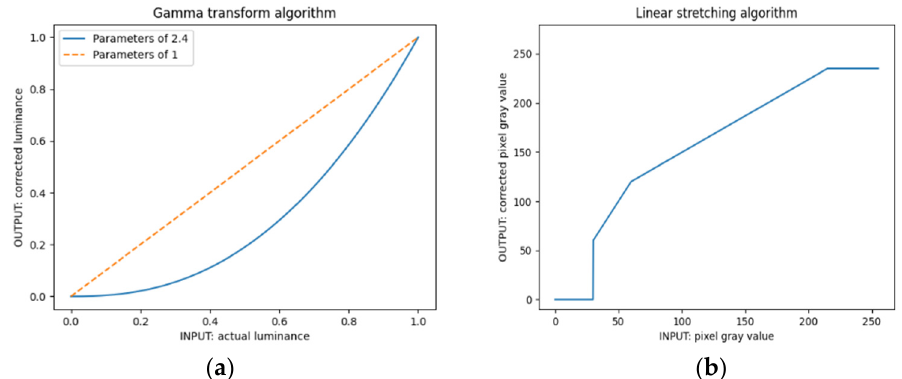
Figure 9. ( a ) Gamma transform algorithm with coefficient of 2.4; ( b ) linear stretch algorithm. The gray value of each pixel in image represents the energy of a certain point of the target at a certain distance, so the radar original reconstruction image indicates that the SAR image has the characteristic that the reflected energy of the target is higher than the